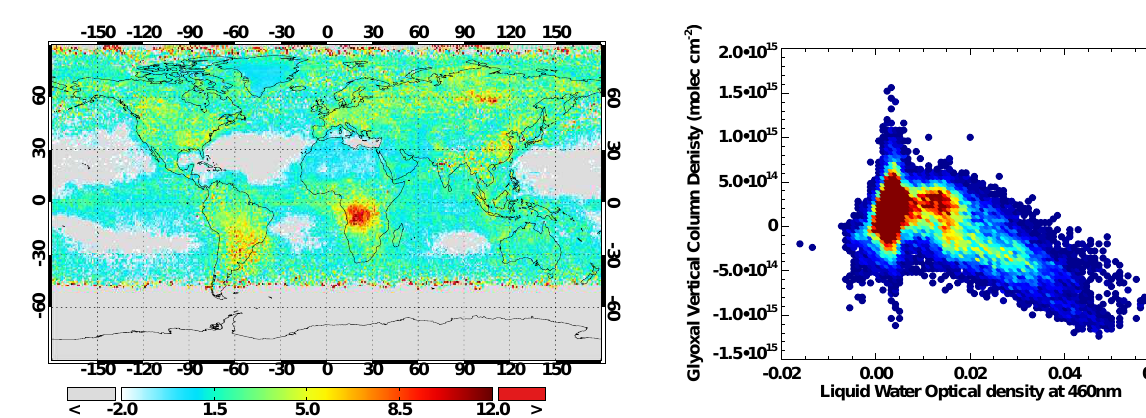
Figure 14. Scatter plot of glyoxal slant column densities (moleculescm − 2 ) retrieved for July 2006 and liquid water optical depth at 460nm. Points are colour coded by the number of pixels falling within the grid cell corresponding to the point in the